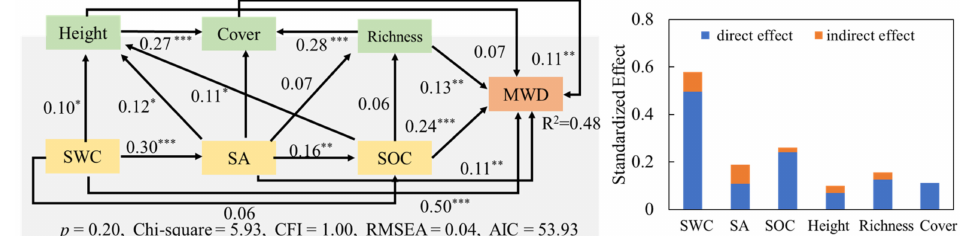
Figure 5. Effects of plant characteristics and soil factors on soil aggregate stability in the river bank. Note: SWC, SA, SOC, Height, Richness, and cover represent soil water content, soil salinity, soil organic carbon, plant height, species richness, and plant coverage, respectively. Black solid lines indicate a positive effect and red dashed lines indicate a negative effect. Values on lines denote the standardized effect size and significance (* p < 0.05; ** p < 0.01; *** p < 0.001).